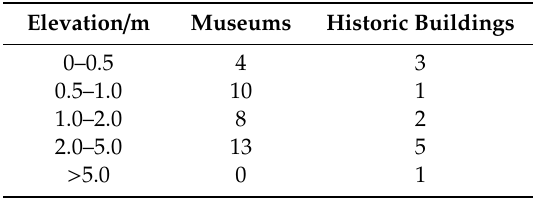
Table 2. Elevation of museums and sites in flood risk